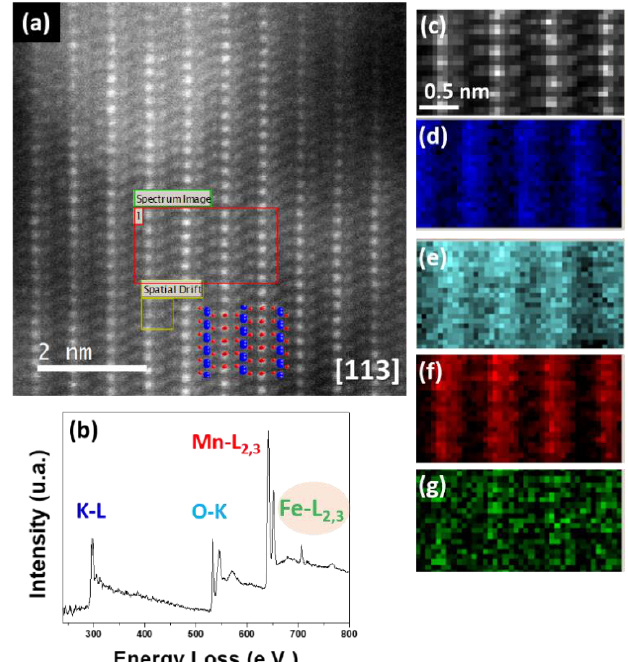
Figure 10. ( a ) STEM-HAADF image corresponding to K 0.09 Mn 0.88 Fe 0.12 O 2 ; ( b ) sum spectra of the area framed in green in a; ( c ) simultaneously acquired HAADF image; ( d ) K-L 2,3 chemical map; ( e ) O-K chemical map; ( f ) Mn-L 2,3 chemical map and ( g ) Fe-L 2,3 chemical map